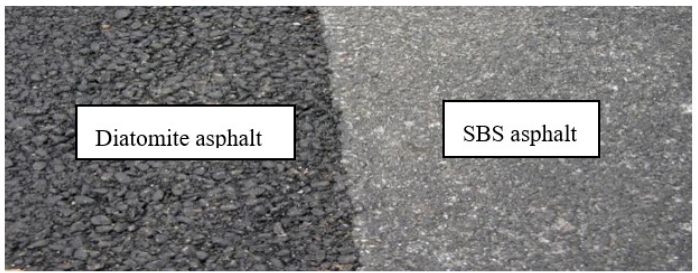
Figure 6. Comparison of test sections between SBS and activated diatomite asphalt pavement.